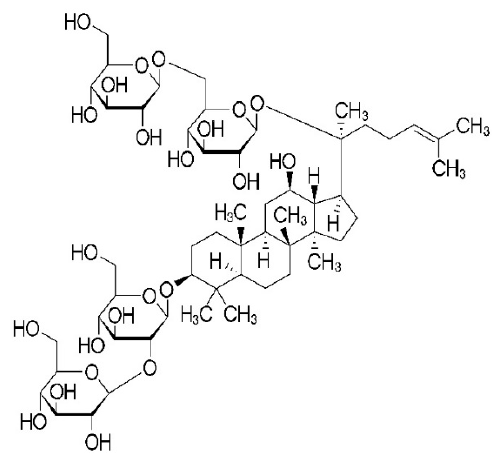
Figure 9. Chemical structure of Ginsenoside Rb1.